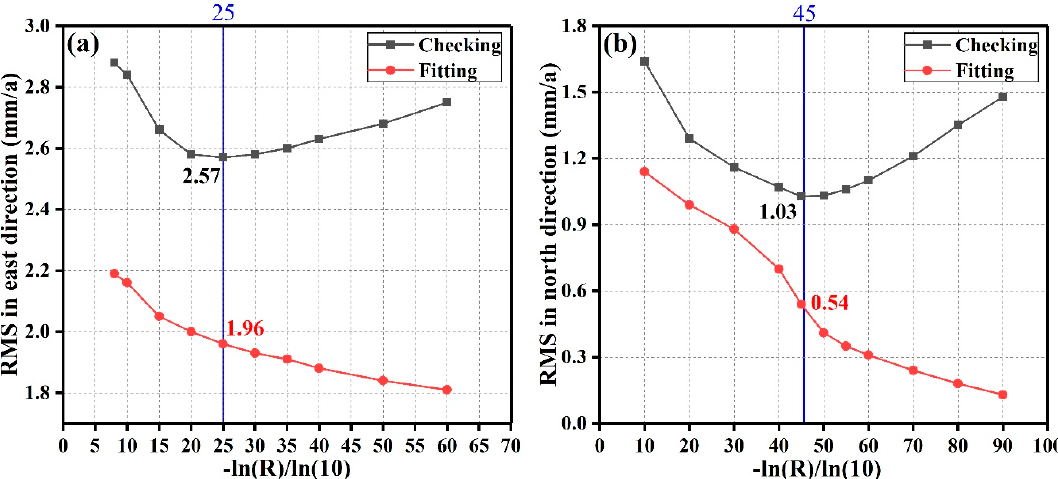
Figure 7. Optimal distance scale factor of the ADLSC in the ( a ) east direction and ( b ) north direction.